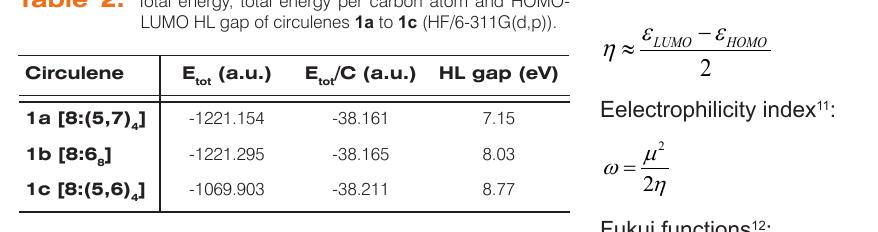
Table 3. NICS(0) values, computed in circulenes 1a to 1c (B3LYP/6-31G(d) level of theory).